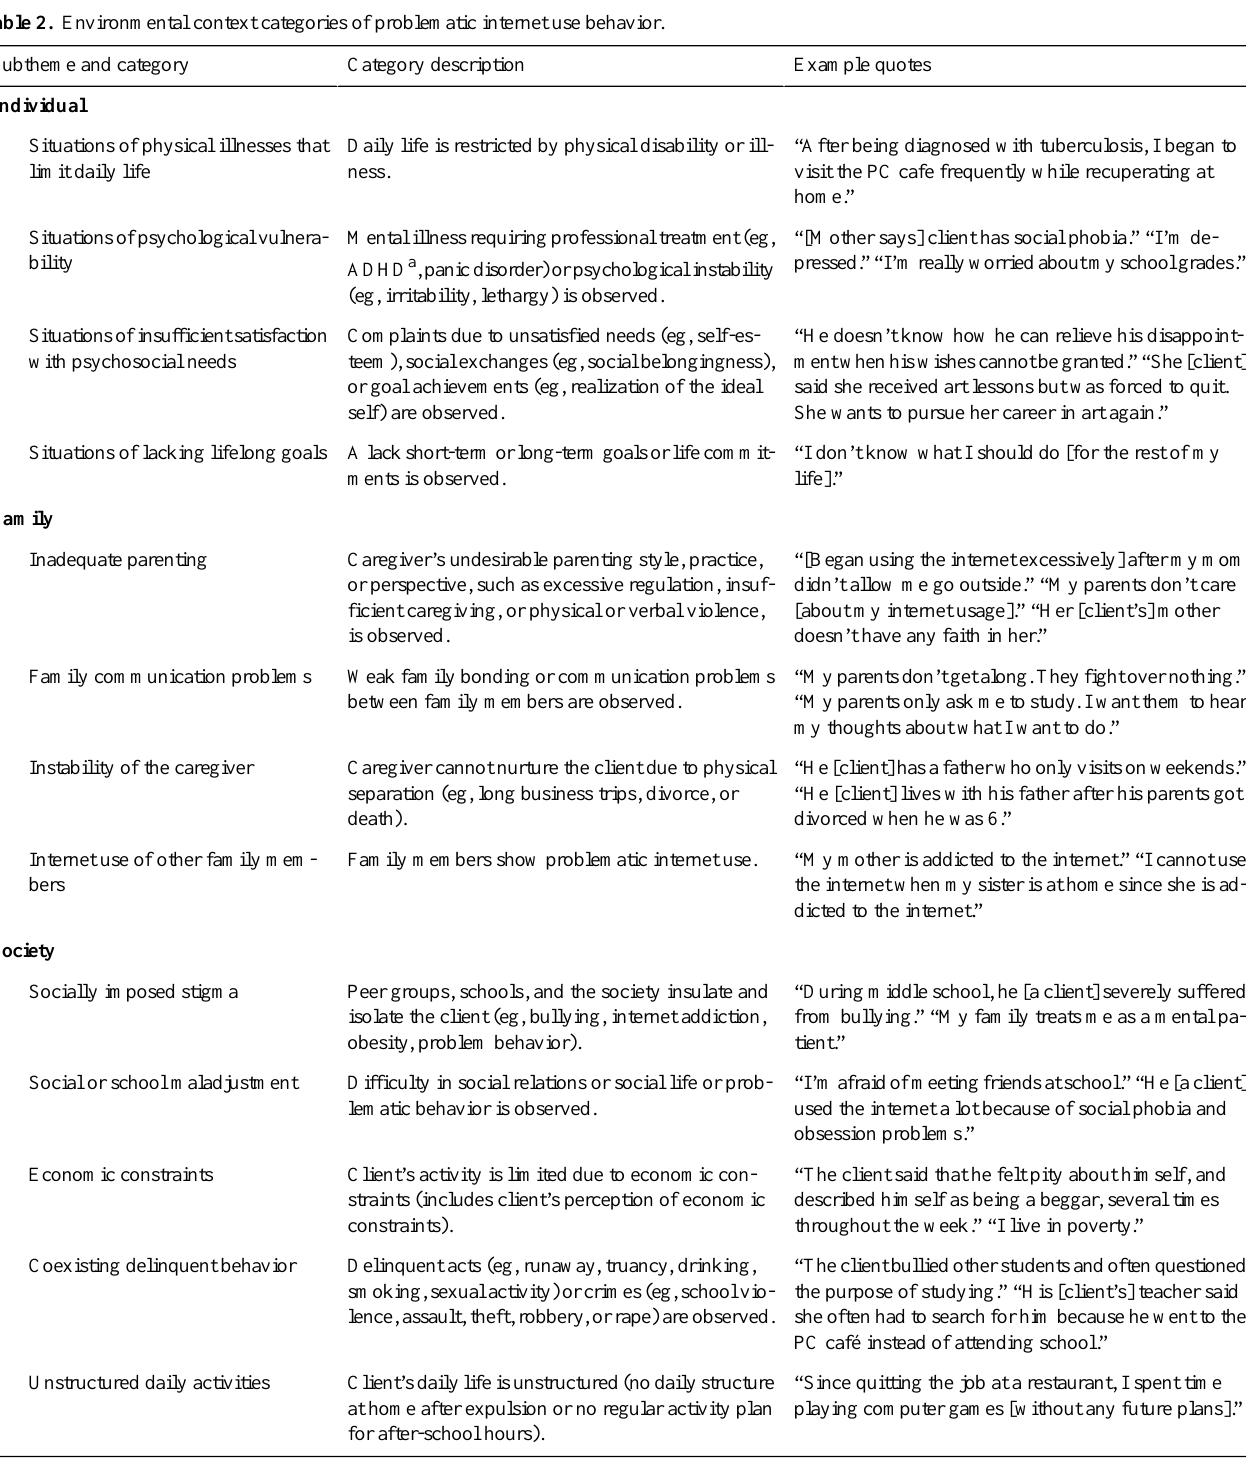
Table 2. Environmental context categories of problematic internet use behavior.